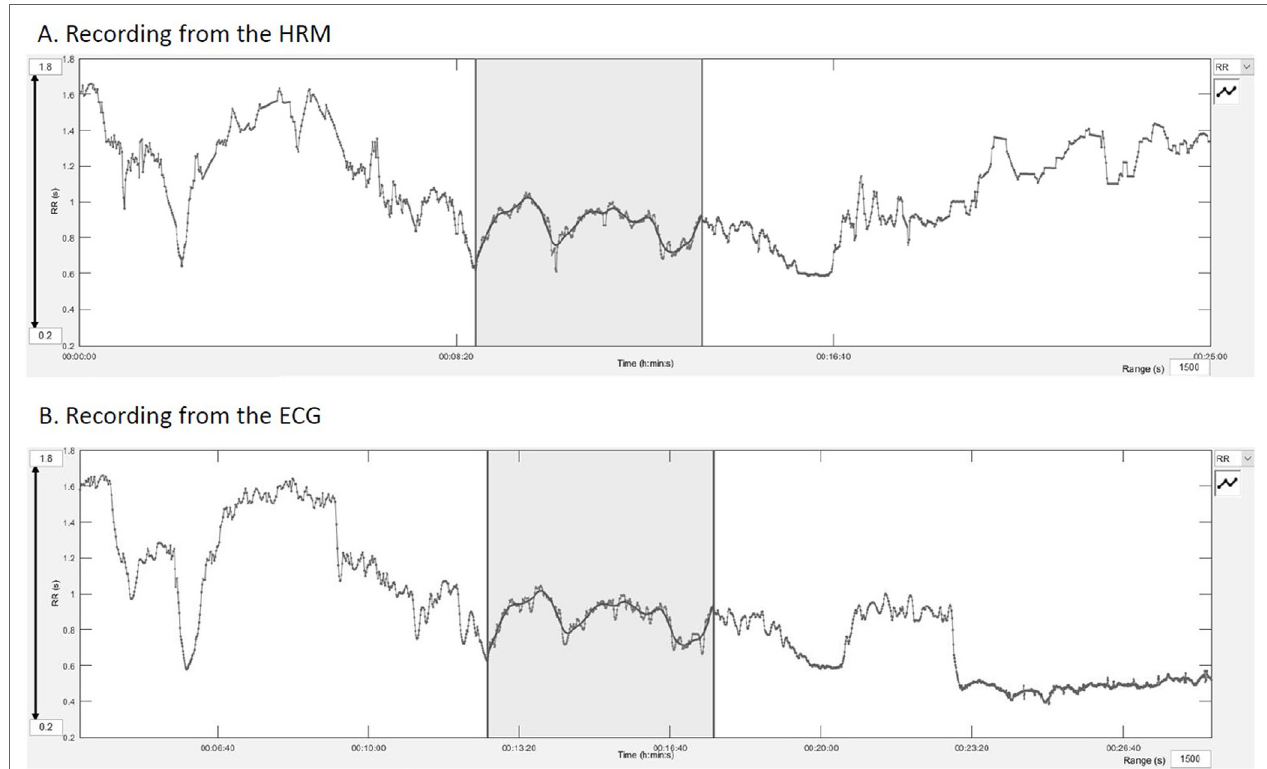
FigUre 3 | Manual synchronization from a common spike on the Kubios ® software. (a) Recording of the HRM, the gray area represents the analyzed part, (B) recording of the electrocardiogram.